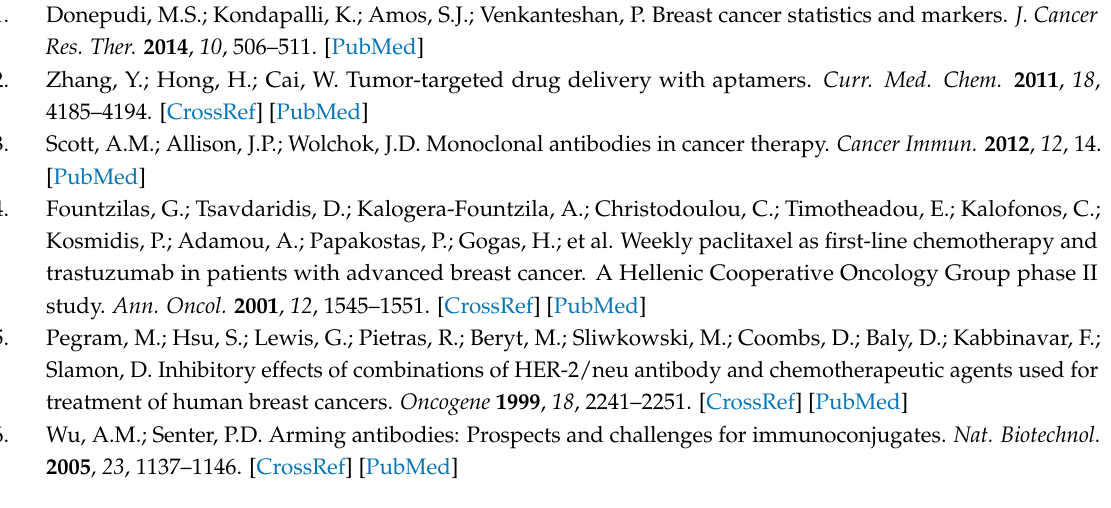
Figure S1: The 1HNMR spectrum of PAMAM-dox conjugate, Figure S2: The FTIR spectrum of PAMAM-dox, Figure S3: RP-HPLC profile of PAMAM G4, trastuzumab and PAMAM–dox–trastuzumab conjugate